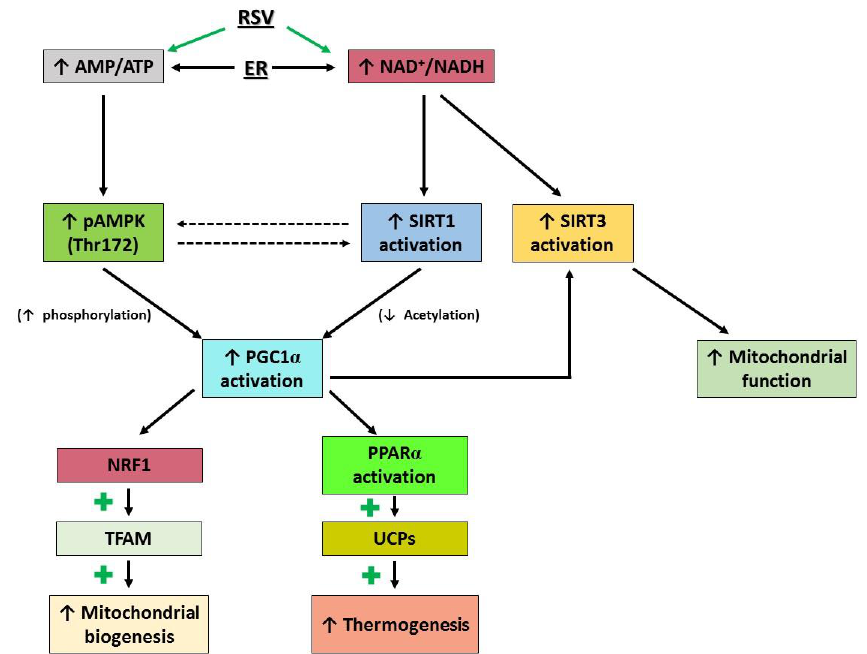
Figure 3. Effects of resveratrol and energy restriction in thermogenesis and mitochondrial synthesis pathways. RSV: resveratrol, ER: energy restriction, AMP: adenosine monophosphate, ATP: adenosine triphosphate, NAD + : oxidized nicotinamide adenine dinucleotide, NADH: reduced nicotinamide